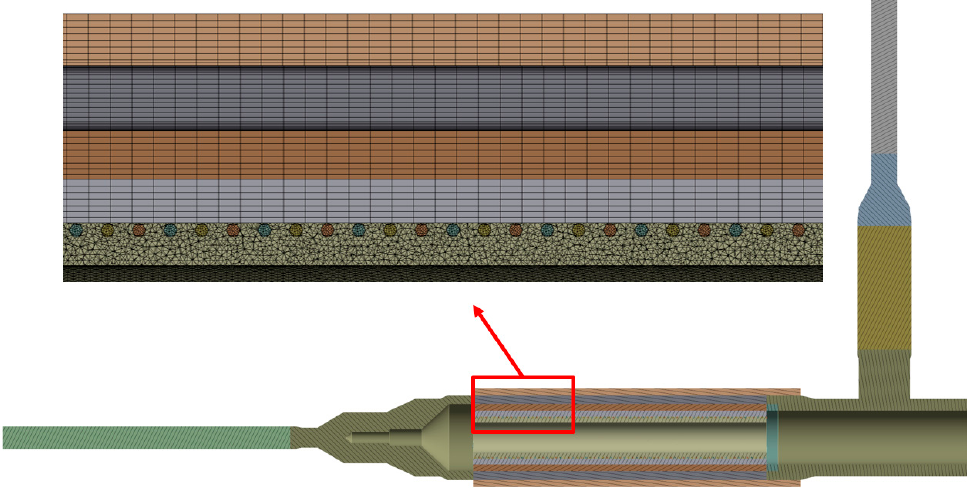
Figure 7. Mesh of the critical region of the